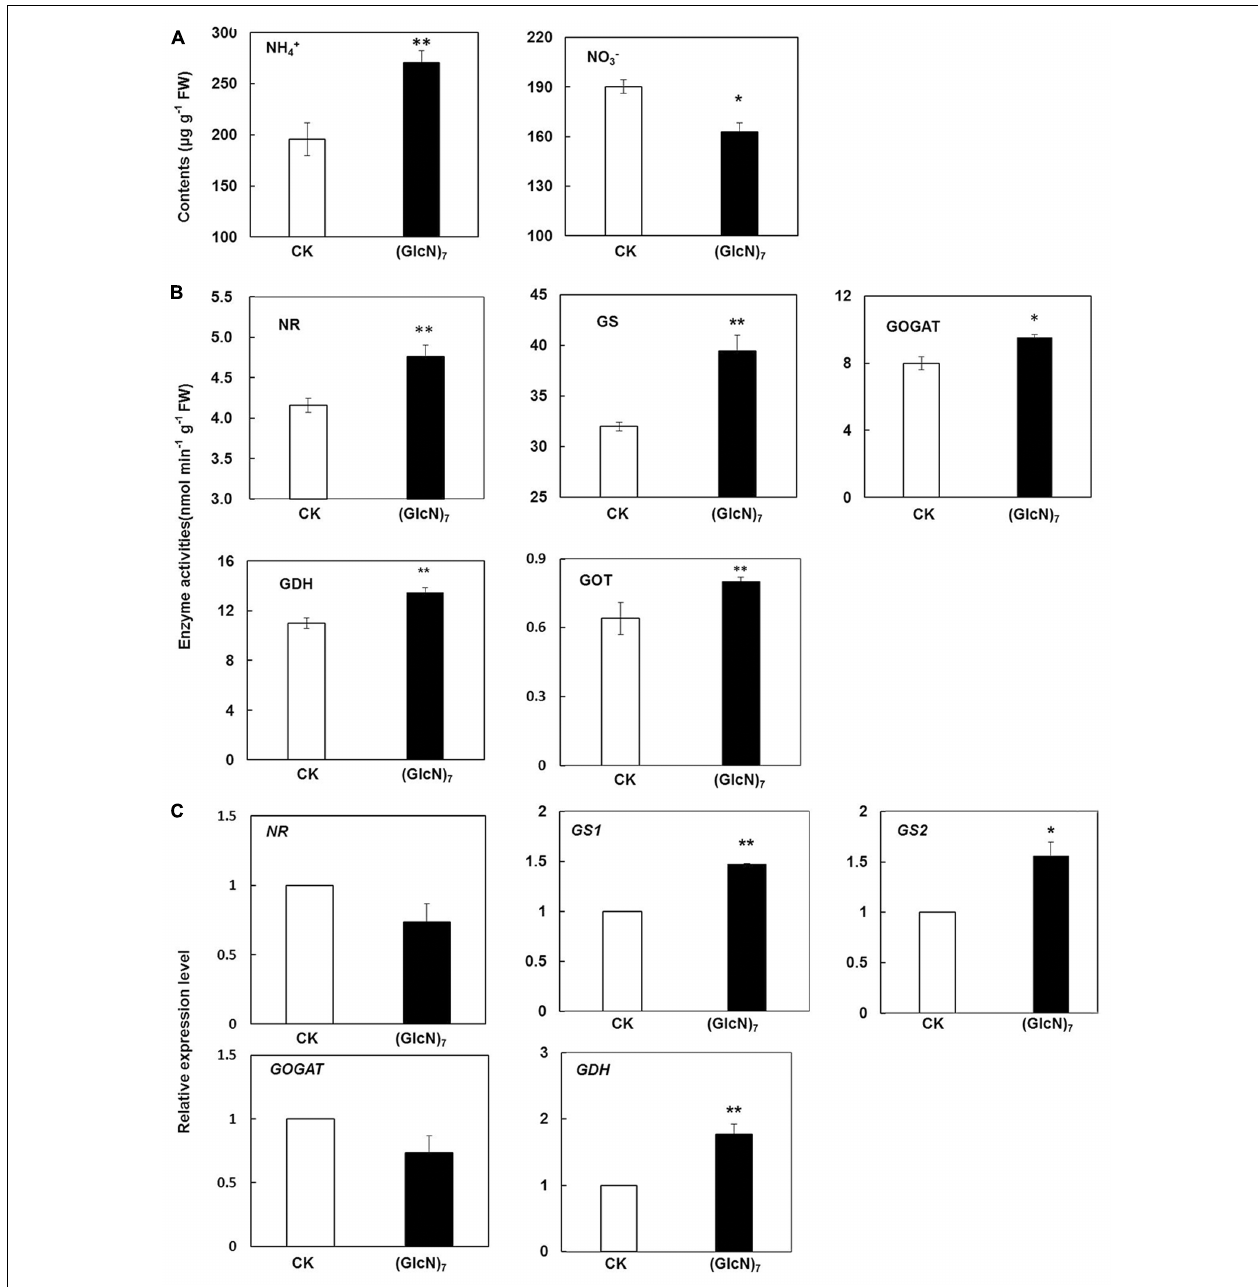
FIGURE 6 | Impacts of (GlcN) 7 on the central N metabolism of wheat seedlings. Metabolite, enzyme activities and transcript levels associated with in wheat seedlings N reduction and N assimilation were analyzed. (A) Contents of NH 4 + and NO 3 − in leaves of CK and (GlcN) 7 treatment group. (B) Relative enzymes activities in N reduction and N assimilation. (C) Relative expression level of key enzymes in N reduction and N assimilation. Relative expression levels are calculated and normalized using β -actin as an internal control. Each value represents means ± SD calculated from four independent biological replicates. Significant differences from the CK are shown ( ∗ P < 0.05, ∗∗ P < 0.01; t